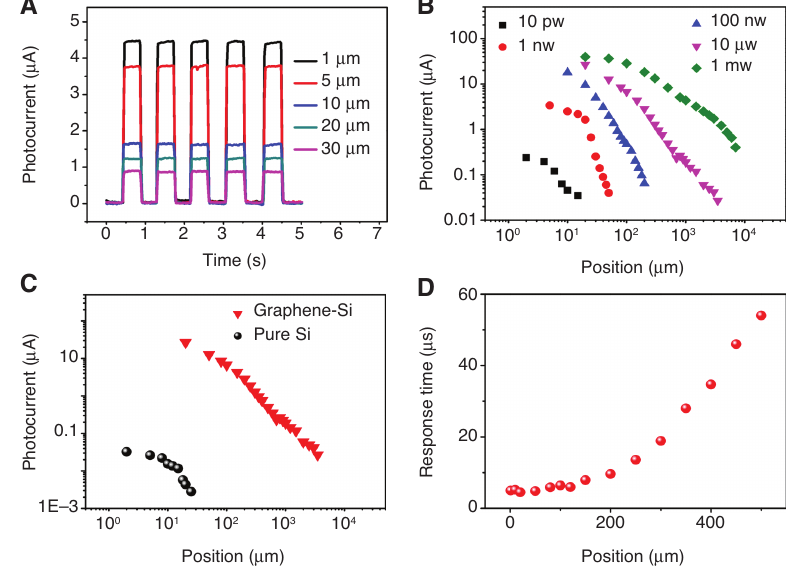
Figure 2: Position-sensitive characteristics of the device. (A) Photo-switching characteristics of the device at different position (532 nm laser, V under different incident light powers. (C) The comparison of the position sensitive characteristics of the graphene-Si and pure Si devices under 10 μ W. (D) The position dependence of response time of the